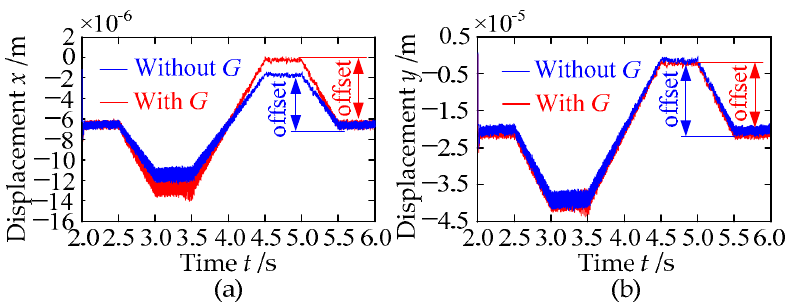
Figure 12. Displacement responses with or without additional inertial forces of node 14 when a x changes from 10 to − 10 m·s − 2 : ( a ) x -direction; ( b ) y -direction.